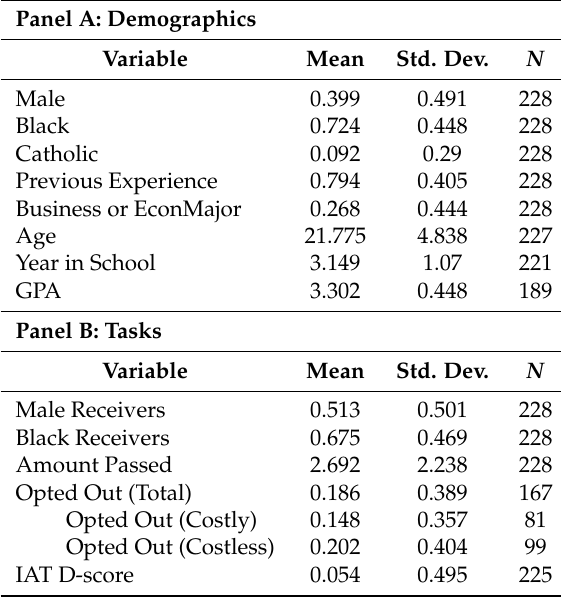
Table 3. Experimental summary statistics (dictators